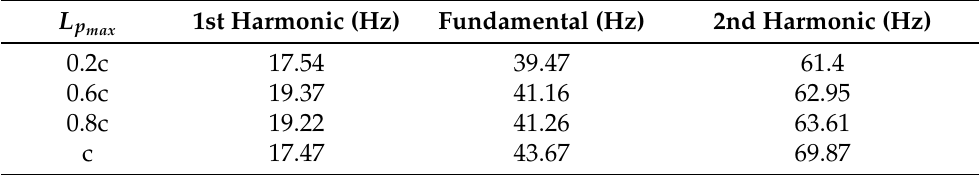
Table 1. Frequencies spectrum of the hydrofoil motion for different L p